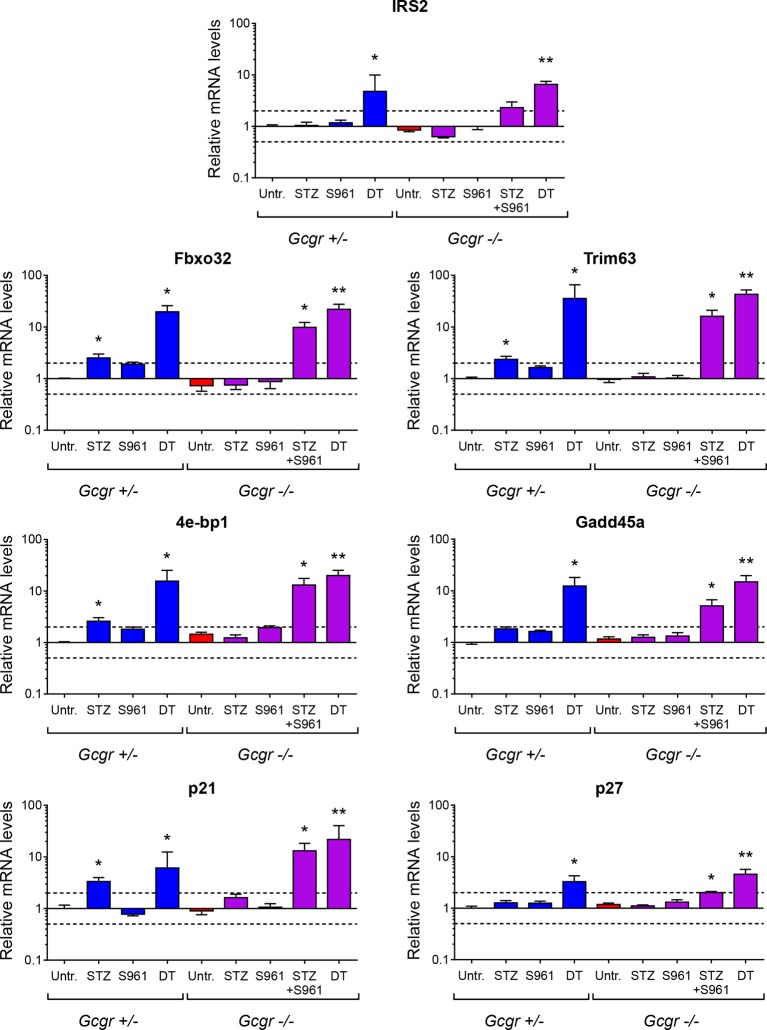
Expression of genes negatively regulated by insulin signaling in skeletal muscle.mRNA levels of genes inhibited by insulin in skeletal muscle (gastrocnemius), relative to those of untreated Gcgr+/- females (normalized to Actb, Gapdh, and Gusb) (N=4–6). Irs2, Insulin receptor substrate 2; Fbxo32, F-box only protein 32 (Atrogin-1); Trim63, Tripartite motif-containing 63 (MuRF1); 4e-bp1, Eukaryotic translation initiation factor 4E binding protein 1 (Eif4ebp1); Gadd45a, Growth arrest and DNA-damage-inducible 45 alpha; p21, Cyclin-dependent kinase inhibitor 1A (Cdkn1a). p27, Cyclin-dependent kinase inhibitor 1B (Cdkn1b). *p<0.05; **p<0.01; Mann-Whitney U test. Only groups that exhibited a > twofold regulation as compared to controls (dashed lines) were tested.